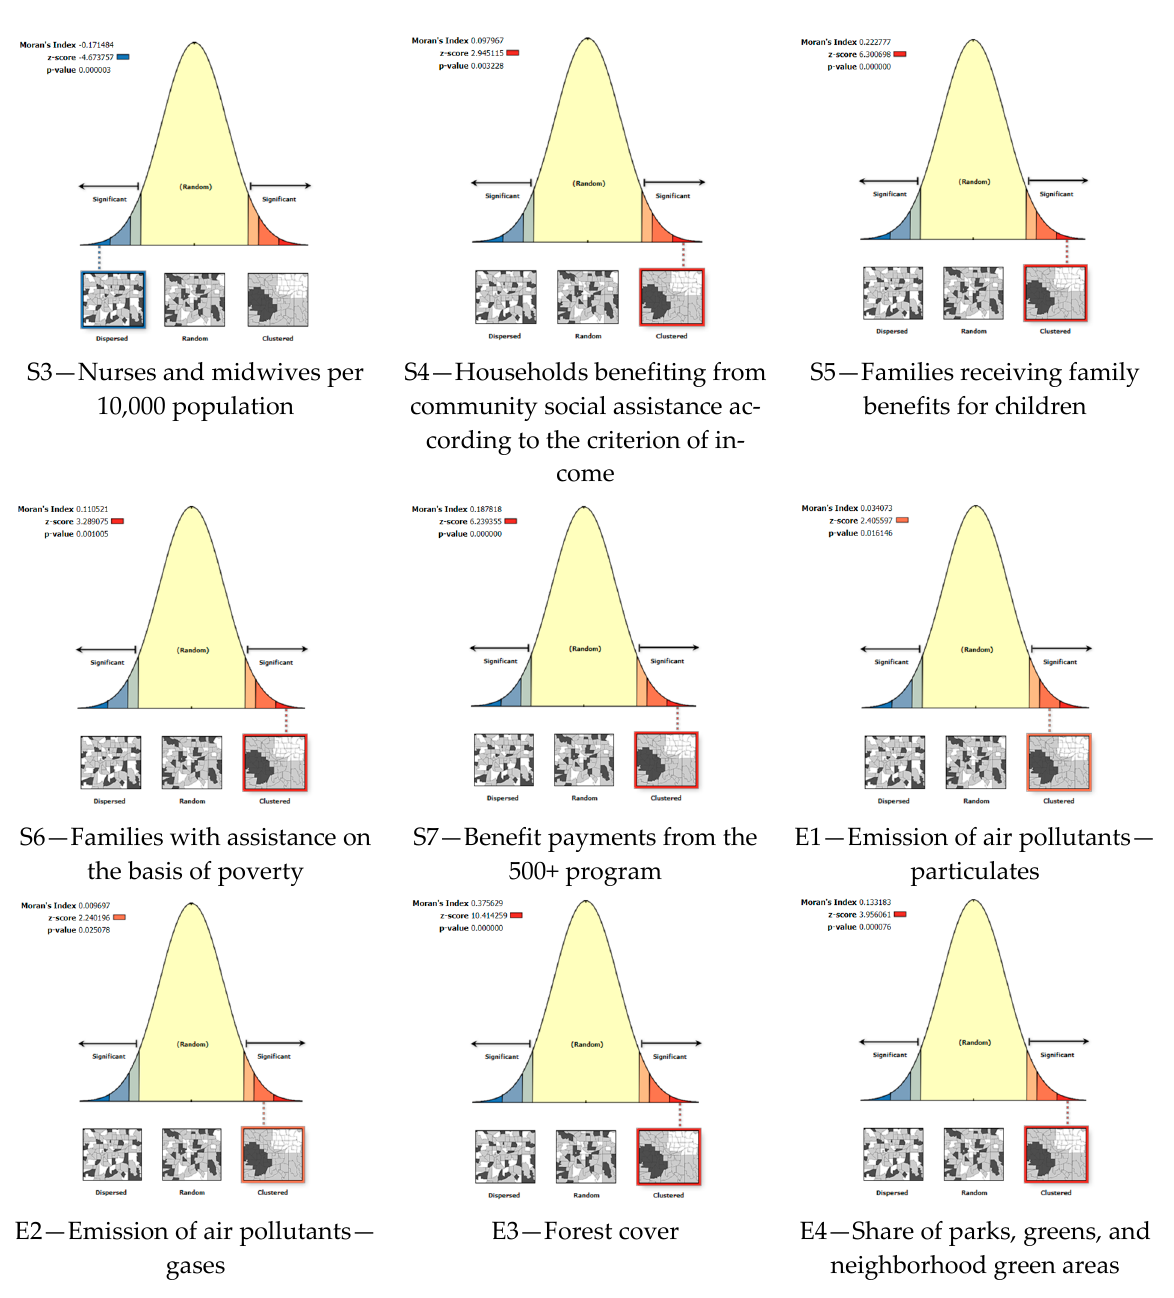
Figure 4. Spatial autocorrelation reports. Source: own elaboration using ArcGIS Pro 2.9 by Esri. A positive z-score indicates a tendency to form clusters, and it has a negative aspect—a tendency for the data to be dispersed [100,101]. The following, in Table 2, summarizes the results of the spatial autocorrelation, with the p -value, the z-score, an indication of the spatial pattern, and the confidence level for all the analyzed variables. Table 2. Summary of the spatial autocorrelation. Source: own elaboration on the basis of ArcGIS Pro 2.9 by Esri.